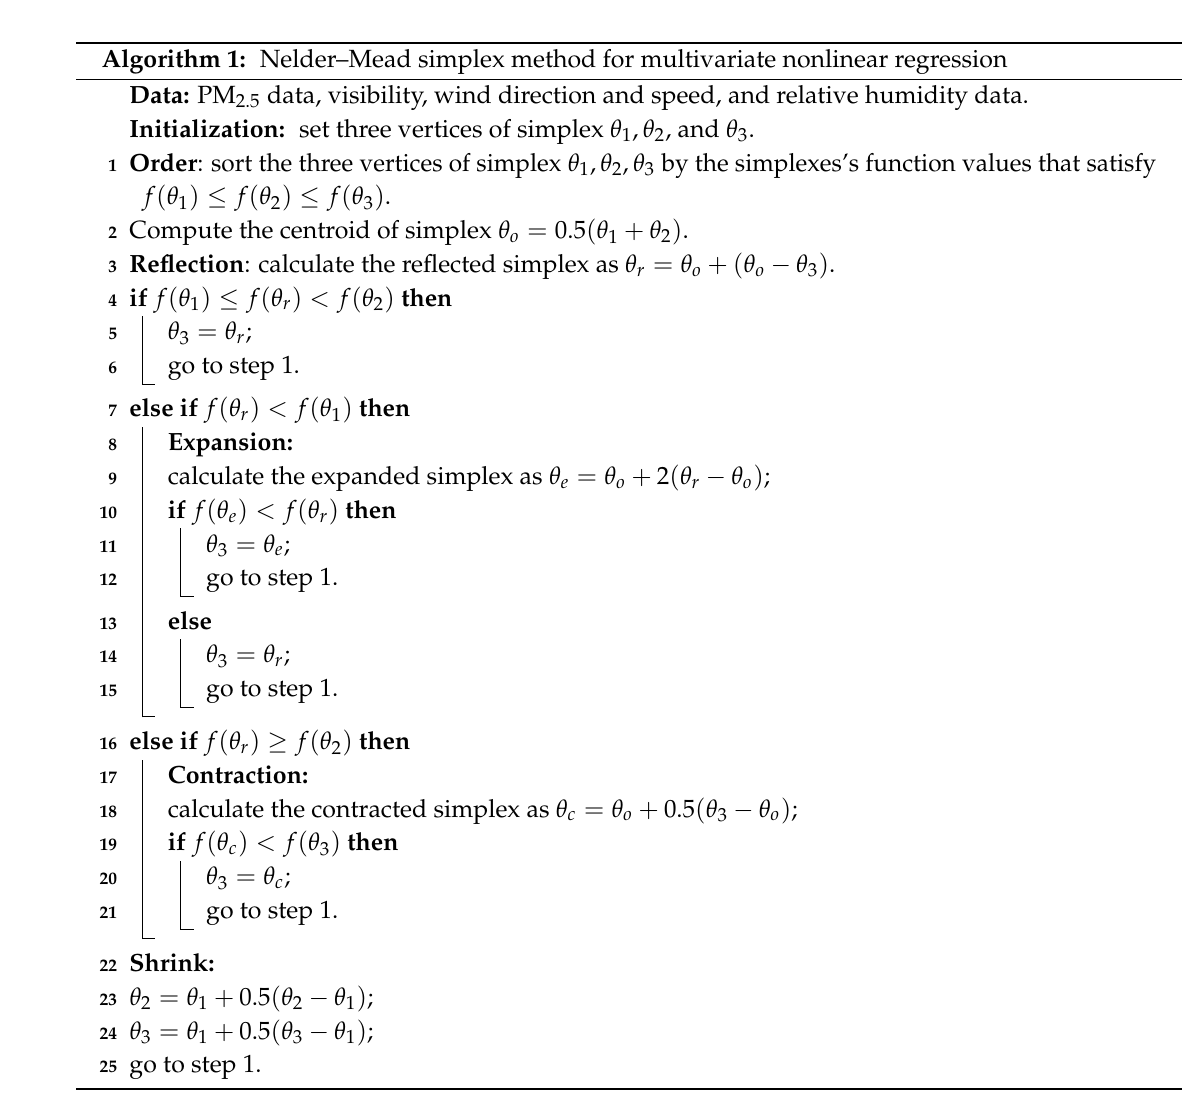
Algorithm 1: Nelder–Mead simplex method for multivariate nonlinear regression